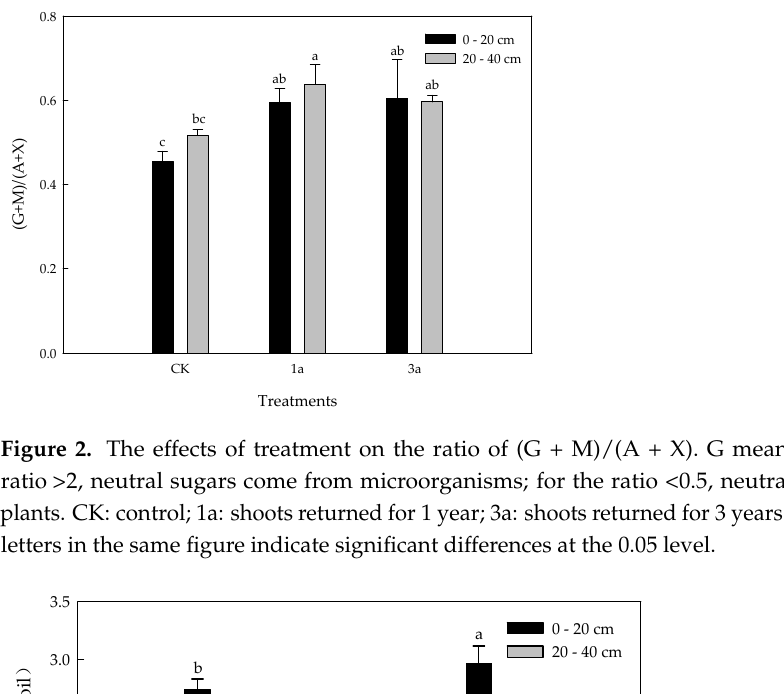
Figure 2. The effects of treatment on the ratio of (G + M)/(A + X). G means galactose; for the ratio >2, neutral sugars come from microorganisms; for the ratio <0.5, neutral sugars come from plants. CK: control; 1a: shoots returned for 1 year; 3a: shoots returned for 3 years. Different lowercase letters in the same figure indicate significant differences at the 0.05 level.